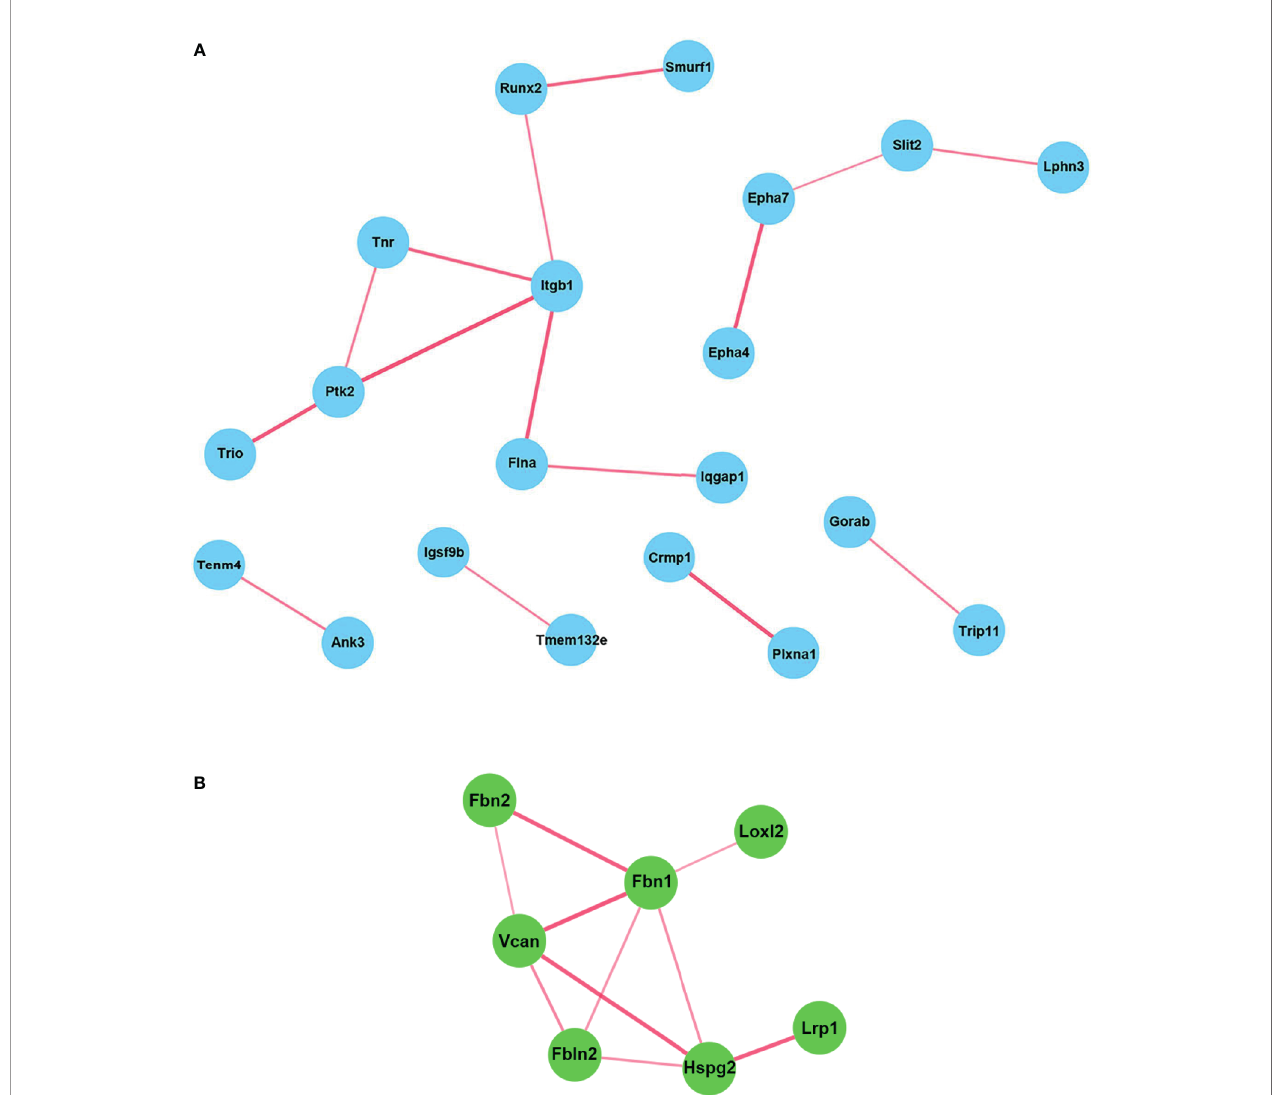
FIGURE 4 | STRING network analysis of the individual genes. The genes belonging to the BP “ Nervous system development ” (A) and those whose TGF- b - regulated levels were signi fi cantly higher in WT astrocytes than in RGC-32 KO astrocytes (B) were uploaded into the STRING online platform in order to generate a network of functionally interconnected genes. Each node represents an individual gene. The edges between nodes represent physical and functional gene product associations. The thickness of the lines is directly proportional to the strength of the data support. The genes that showed no connectivity were excluded. Some of the functionally interacting genes encode members belonging to several families of proteins, including ephrin type A receptors (Epha4 and Epha7), beta integrins (Itgb1), Runt-related transcription factors (Runx2), plexins (Plxna1), protein tyrosine kinases (Ptk2), tenascins (Tnr), teneurins (Tenm4), and Robo-Slit signaling (Slit2) (A)